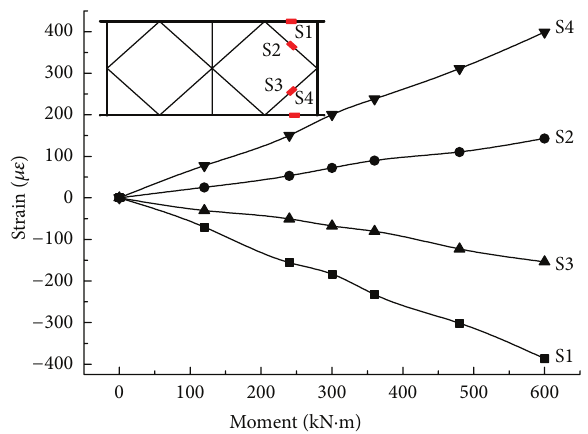
Figure 15: The relationship between the equivalent bending moments and experimental values of strain for Side-A.